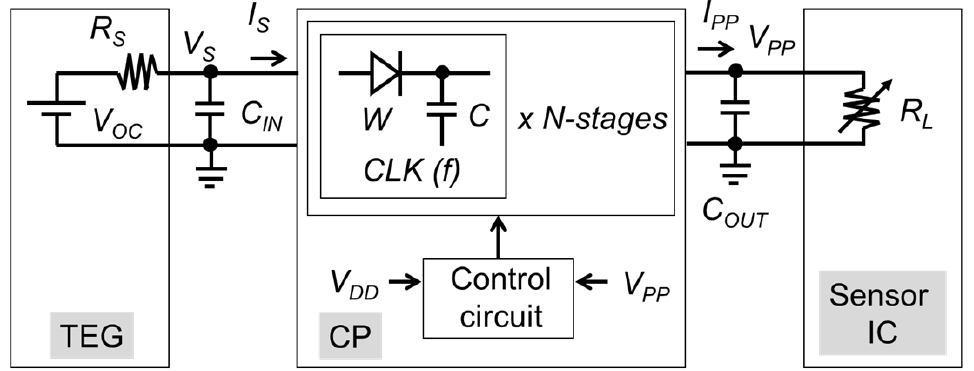
Figure 1. Circuit diagram of CP with TEG as a power source and sensor IC as a load.